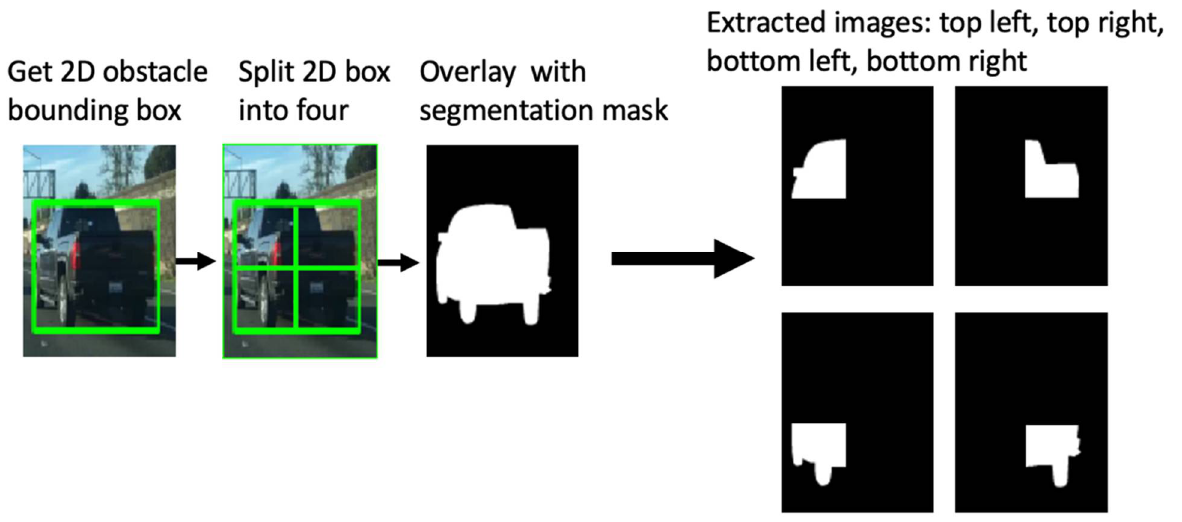
Figure 15. Extracting the obstacle quarters from the original segmentation mask and 2D obstacle bounding boxes. Image source [36].